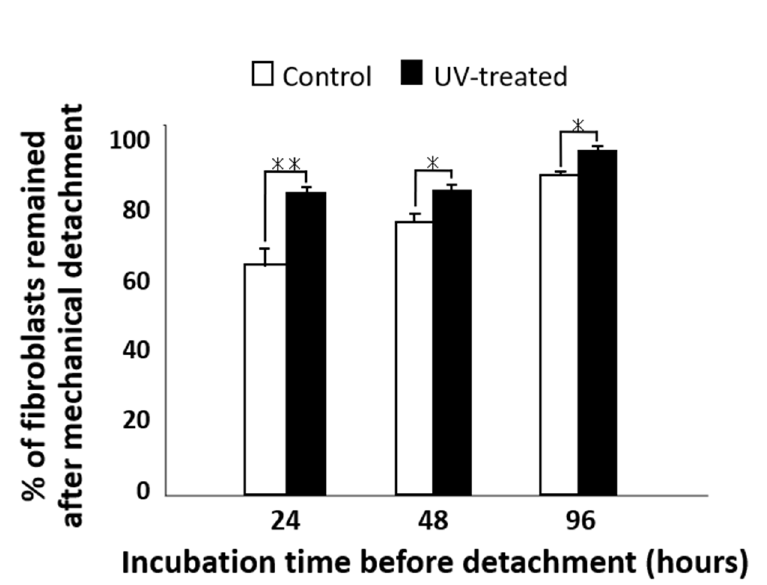
Figure 5. Percentage of attached fibroblasts remaining after mechanical detachment; cells were cultured for 24, 48, and 96 h on titanium disks with and without UV treatment. Data are mean ± SD ( n = 6). ** p < 0.01, * p < 0.05, statistically significant difference between the control and UV-treated surfaces.